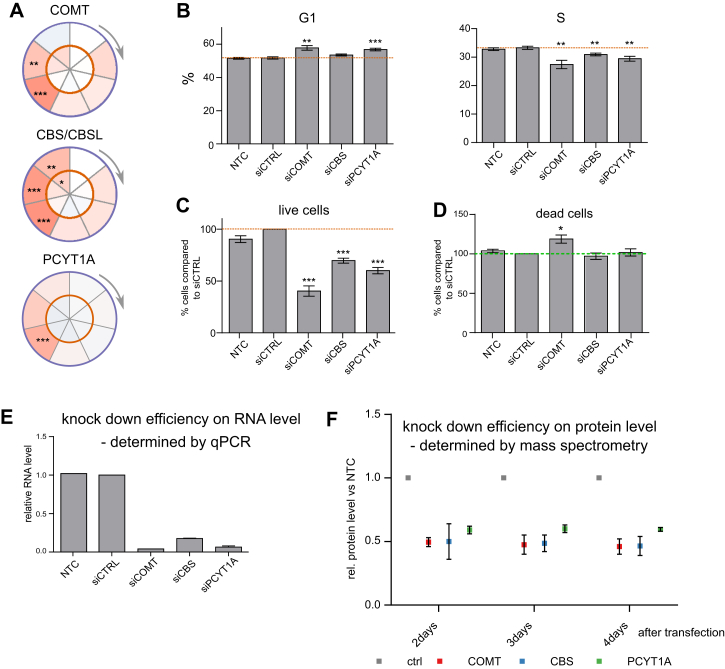
Related to Figures 3B and 3C(A) Circle plots for potential new cell cycle markers changing in their stability during the cell cycle (COMT, CBS/CBSL, PCYT1A).(B) Knock-down of the proteins shown in A results in significant changes in percentage of cells in G1 and S (assessed after 4 days knock-down by PI staining and flow cytometry).(C) Knock-down of the proteins shown in A results in significant changes in percentage of live cells (assessed after 4 days knock/down using a cytotoxicity assay) compared with siCTRL.(D) Knock-down of the proteins shown in A results in minor changes in percentage of dead cells (assessed after 4 days knock/down using a cytotoxicity assay).(E) Knock down efficiency on mRNA level (qPCR), two biological replicates.(F) Knock down efficiency on protein level (mass spectrometry-based quantification), two biological replicates. SEM is shown.